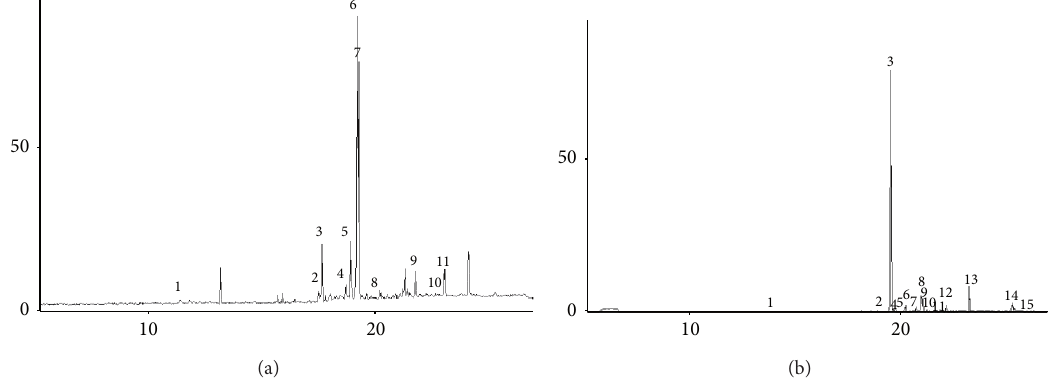
Figure 2: (a) Typical GC trace of volatile organic compounds emitted by nonattacked Populus x canadensis clone “Conti 12” (1: Salicylic aldehyde ∗∗ , 2: 𝛼 -copaene ∗∗∗ , 3: 𝛽 -elemene ∗∗ , 4: N.I., 5: 𝛽 -chamigrene ∗∗ , 6: 𝛽 -selinene ∗∗ , 7: 𝛼 -selinene ∗∗ , 8: N.I., 9: aldehyde of Rt 21.82∗∗ , 10: N.I., and 11: N.I.). ∗∗ : Tentatively identified against GC-MS library, ∗∗∗ : identified against authentic standard, and N.I.: nonidentified.